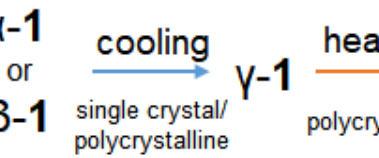
Figure 9. Dependence of the relaxation time τ on the reciprocal temperature for 1 at Н = 1000 Oe. Lines show approximations of the curves by Orbach (blue dashed line) and sum of Raman and direct (red solid line) relaxation